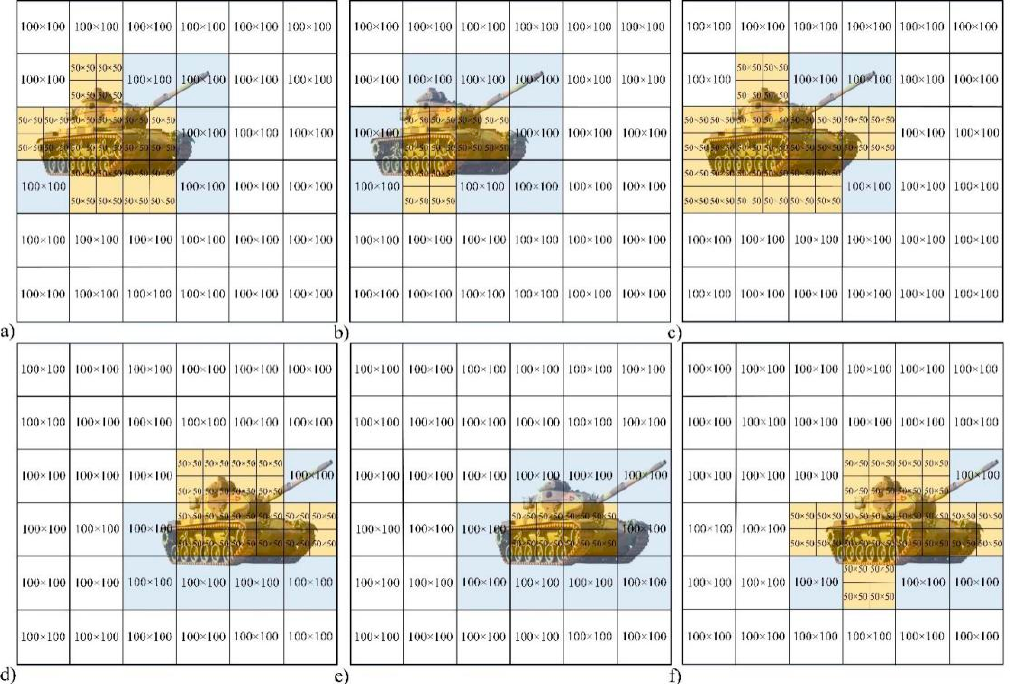
Figure 8. CS measurement scheme diagram with two target positions and three thresholds.